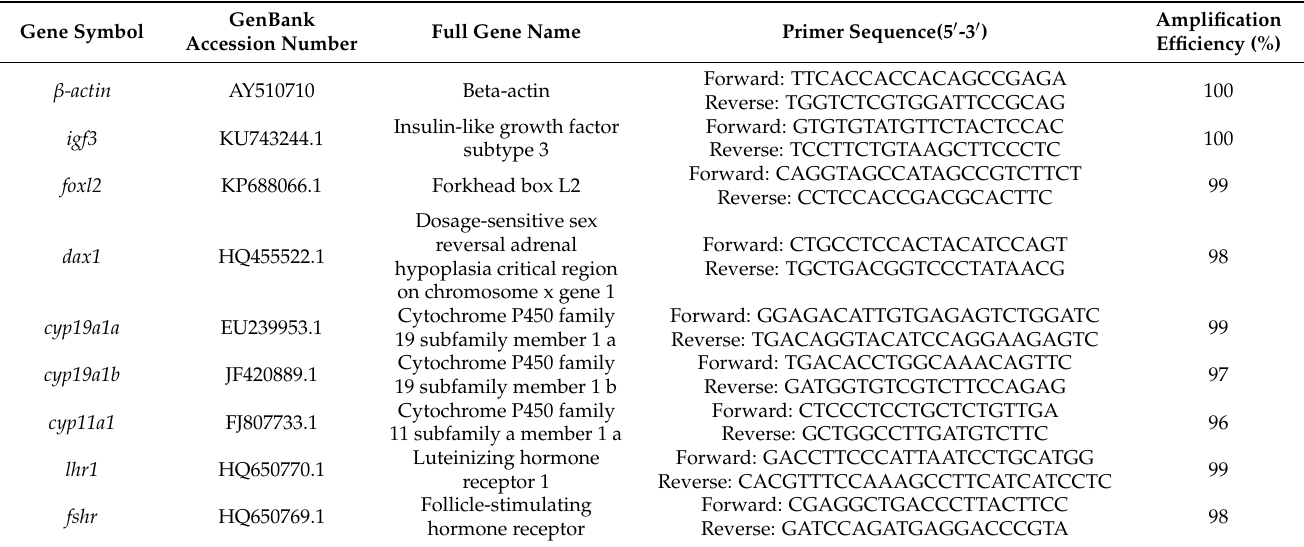
Table 1. Primers used in this